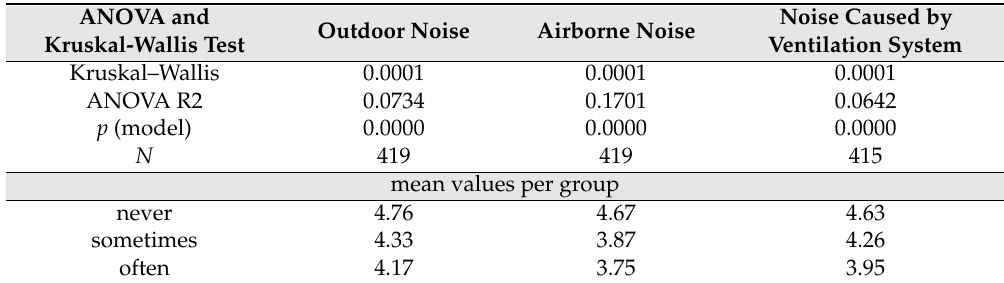
Table 11. ANOVA test for difference in means of satisfaction with acoustic quality and perceived frequency of experienced